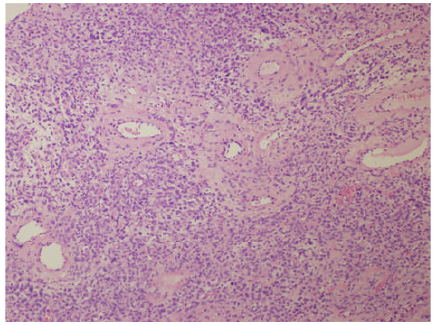
Figure 4: Prominent perivascular hyalinization (HE, × 100).